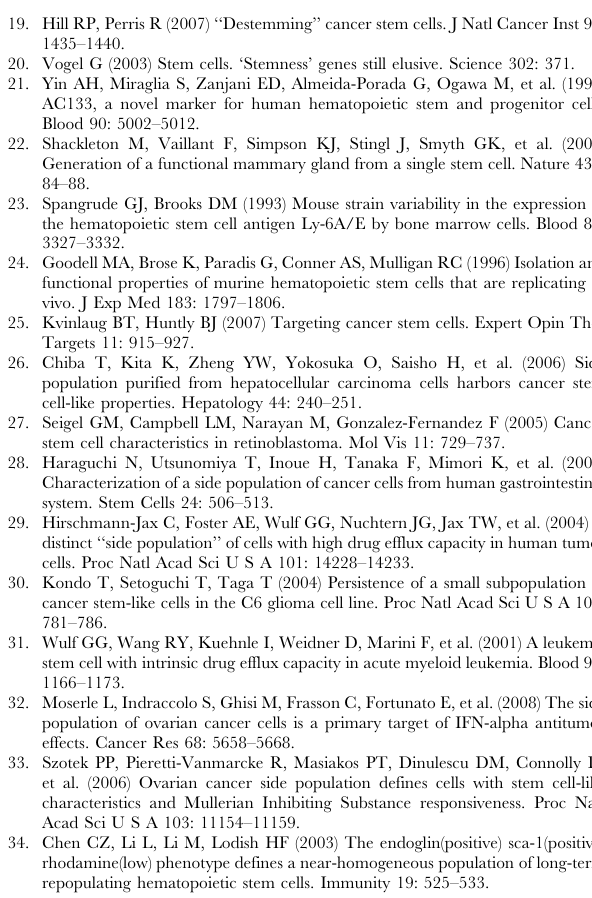
Figure S5 Expression level of Notch target genes in A224 and SKOV3 SP and MP cells. (DOC) Figure S6 Single cell colony forming assay. (DOC) Figure S7 Expression level of transporter genes in A224 SP cells. (DOC) Figure S8 Expression level of PSENEN in A224 and SKOV3 SP and MP cells. Table S1 Pearson’s and spearman’s analysis results. Table S2 Primer sequence information. Table S3 The relative expression of different cell surface markers on SKOV3 SP and